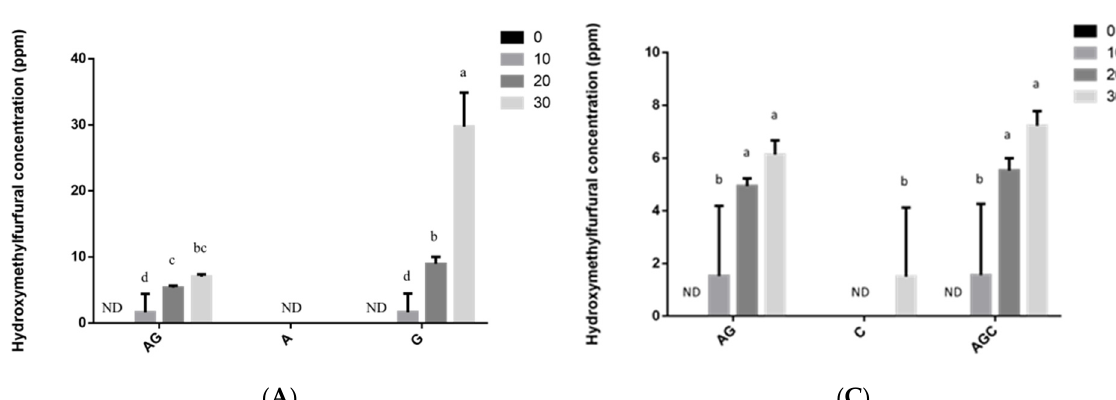
Figure 4. Amounts of hydroxymethylfurfural (ppm) between different groups in: ( A ) AG, G, and A groups dissolved in deionized water, ( B ) HA and H groups dissolved in deionized water, and ( C ) dissolved in acetic acid heated processing duration. AG: asparagine + glucose; A: asparagine; G: glucose; H: hydroxymethylfurfural; HA: hydroxymethylfurfural + ssparagine; C: chitosan; AGC: asparagine + glucose + chitosan. Values are expressed as mean ± standard deviation (SD) ( n = 3). a–d Indicate significant differences between different groups ( p < 0.05).